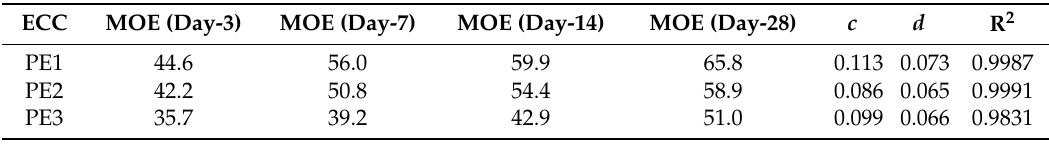
Table 8. Measured MOE (GPa), regression coefficients and goodness of fits for Equation (4).